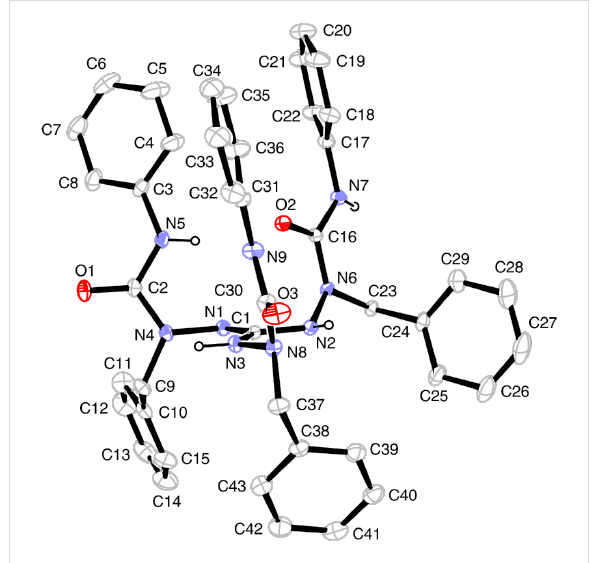
Figure 2: Solid-state structure of 8 . Thermal displacement ellipsoids are drawn at the 20% probability level. Only NH hydrogen atoms are shown, CH hydrogen atoms are omitted for the sake of clarity. Selected bond lengths (Å): C1–N1 1.305(2), C1–N2 1.382(2), C1–N3 1.351(2), N1–N4 1.433(2), N2–N6 1.407(2), N3–N8 1.407(2). Selected bond angles (°): N1–C1–N2 118.8(1), N1–C1–N3 125.0(1), N2–C1–N3 116.2(1). For hydrogen bonds and torsion angles, see Table 1 and Table S4 (Supporting Information File